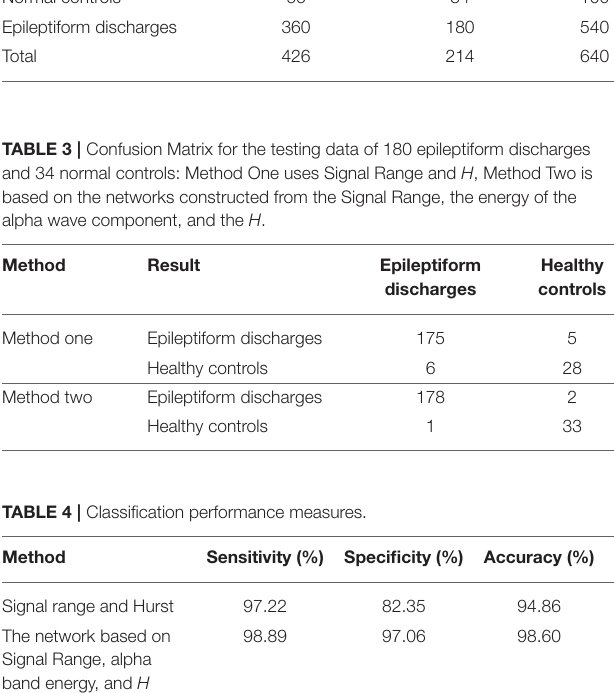
Frontiers in Physiology |